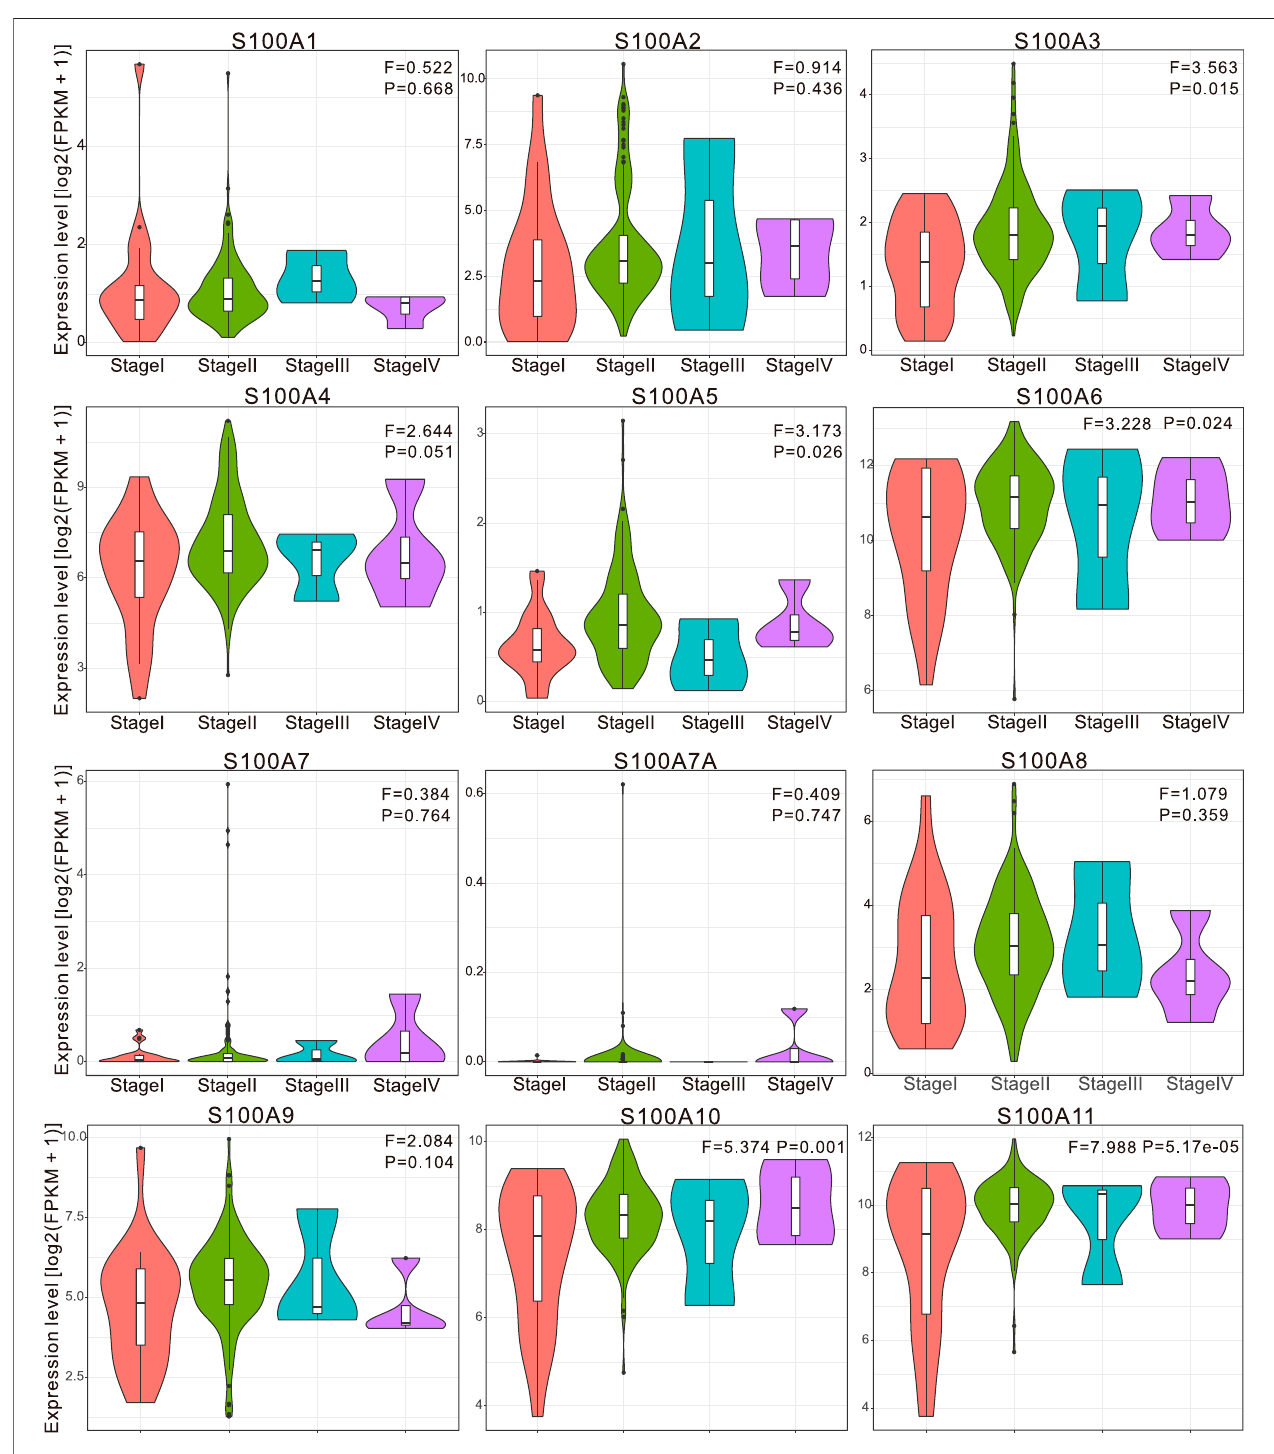
FIGURE4| Violinplotdemonstratedthecorrelation betweenS100stranscriptionlevelandtumor stagesinpatientswithPAAD(calculateddataformTCGAPAAD). ThedifferenceofindividualS100s geneexpression ineach stagewasanalyzedbyone-wayANOVA,inwhichPr( > F) < 0.05wasconsidered tobestatistically signi fi cant. Thenumberofpancreaticcancersamplesateachtumorstagewas21casesinstageI,146instageII,3instageIII,and4instageIV.Abbreviation:Fvalue,thestatistical value of F test; Pr ( > F), p -value